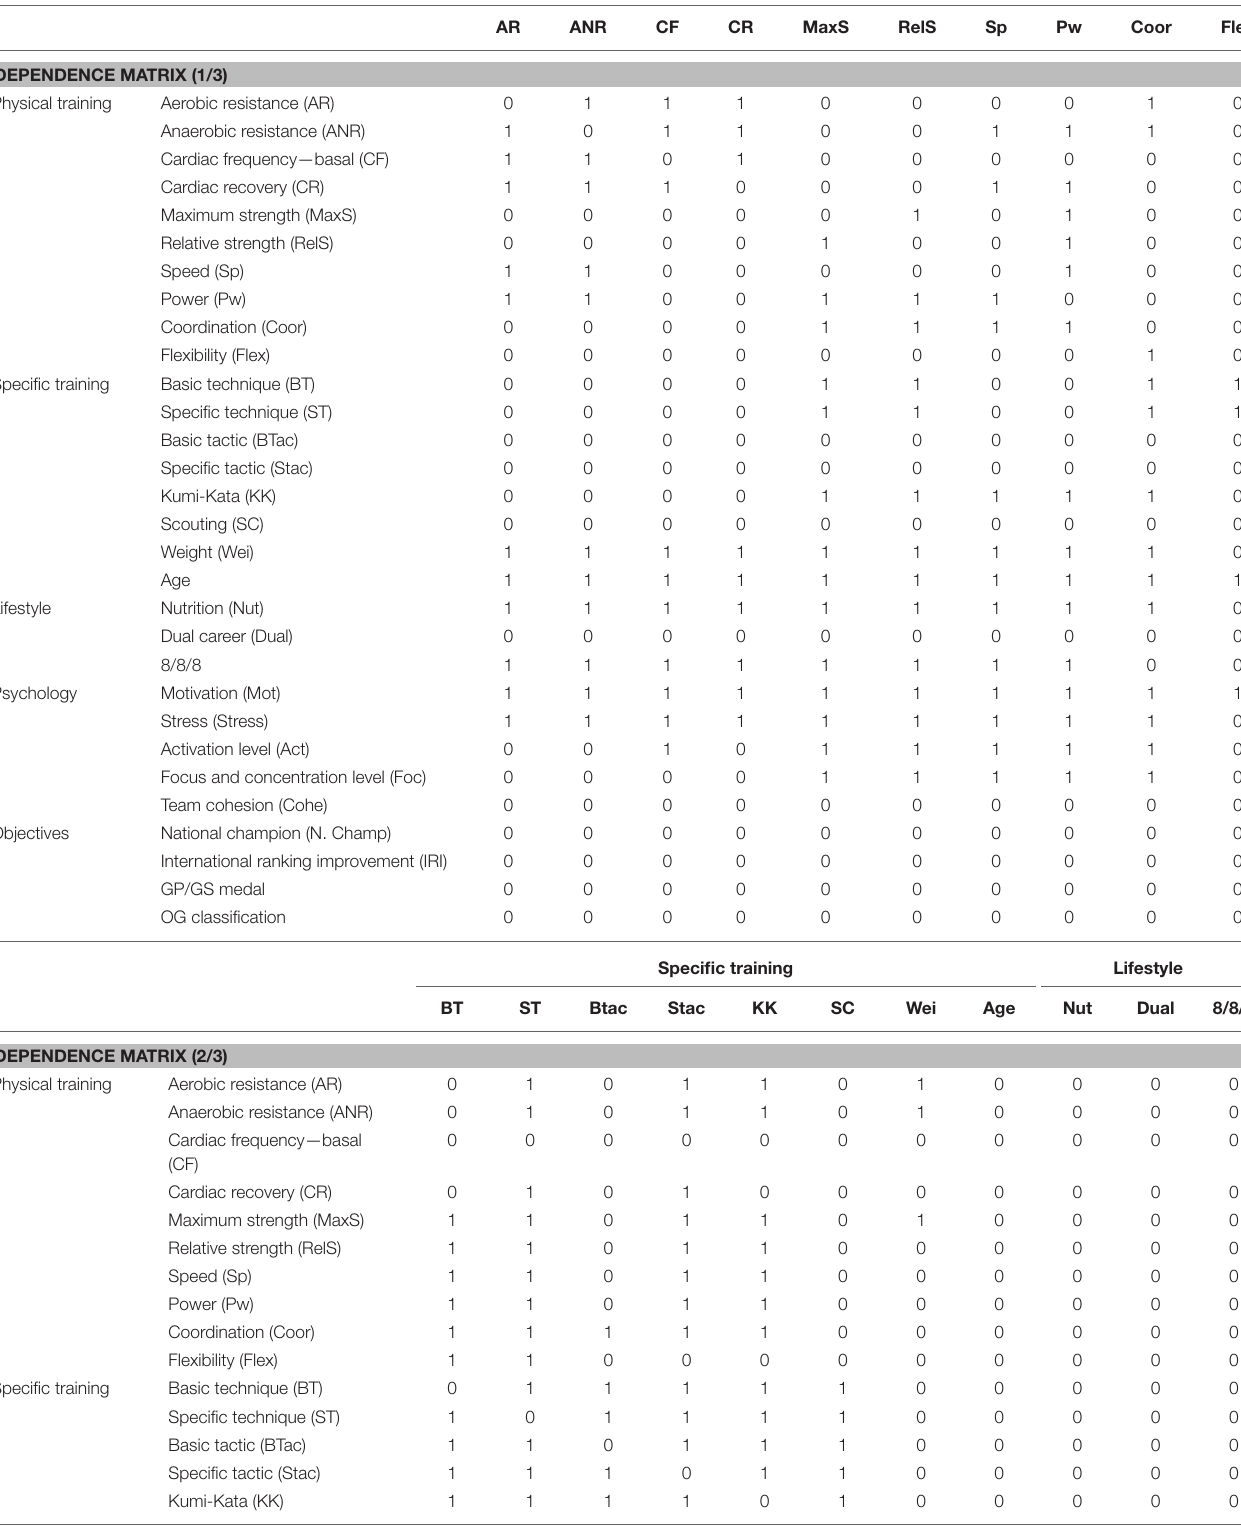
TABLE 3 | Dependence